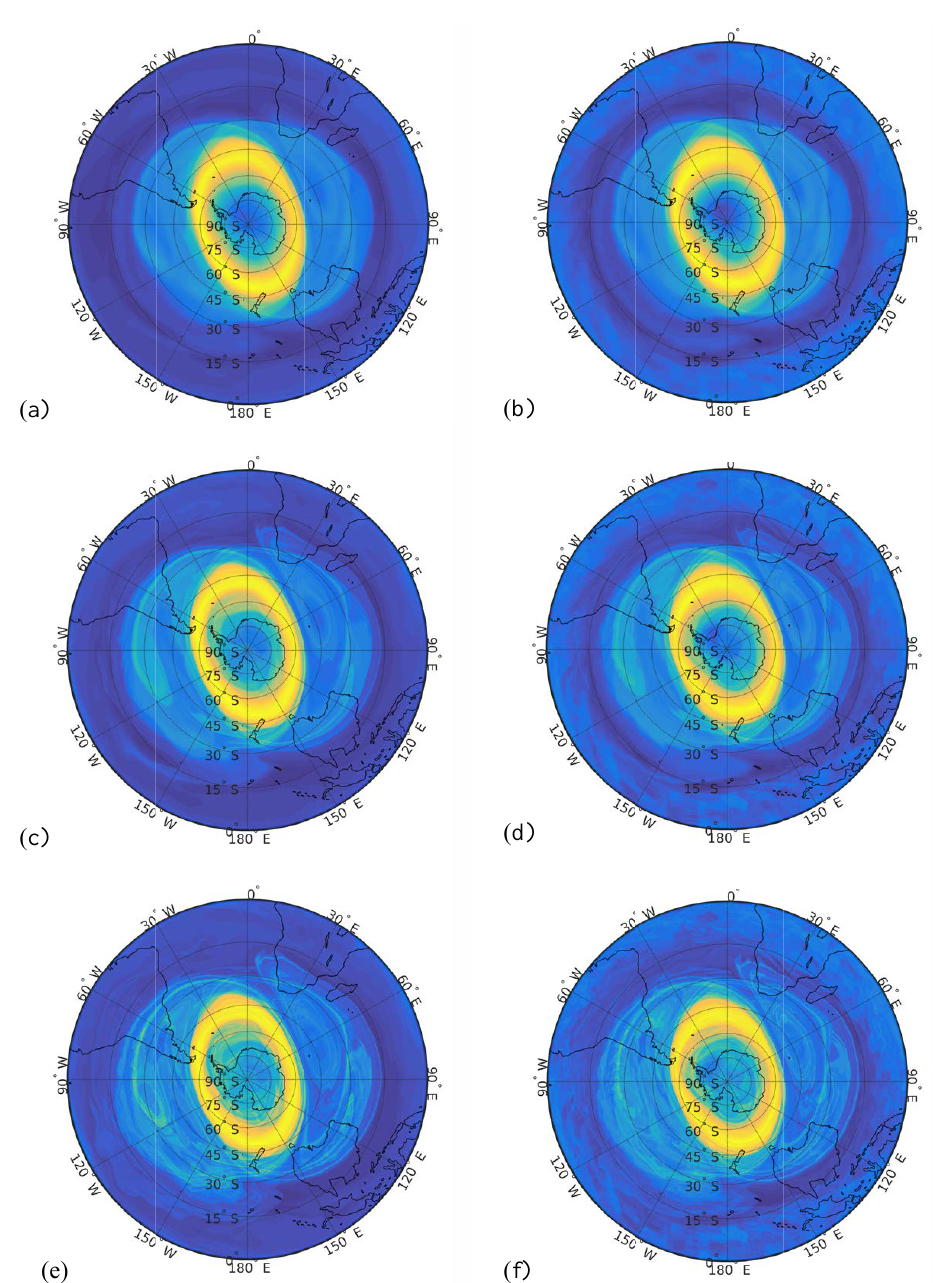
Figure 2. M calculated on 15 August 1979 at 00:00:00UTC: (a) using a 2-D approach where particle trajectories are constrained to the 850K potential temperature level and τ = 5 days; (b) M computation for τ = 5 days using a full 3-D computation of trajectories, and it is represented at a constant height level of h = 31 . 3km (which corresponds approximately to the 850K isentropic surface); (c) the same as panel (a) with τ = 10 days; (d) the same as panel (b) with τ = 10 days; (e) the same as panel (a) with τ = 20 days; (f) the same as panel (b) with τ = 20